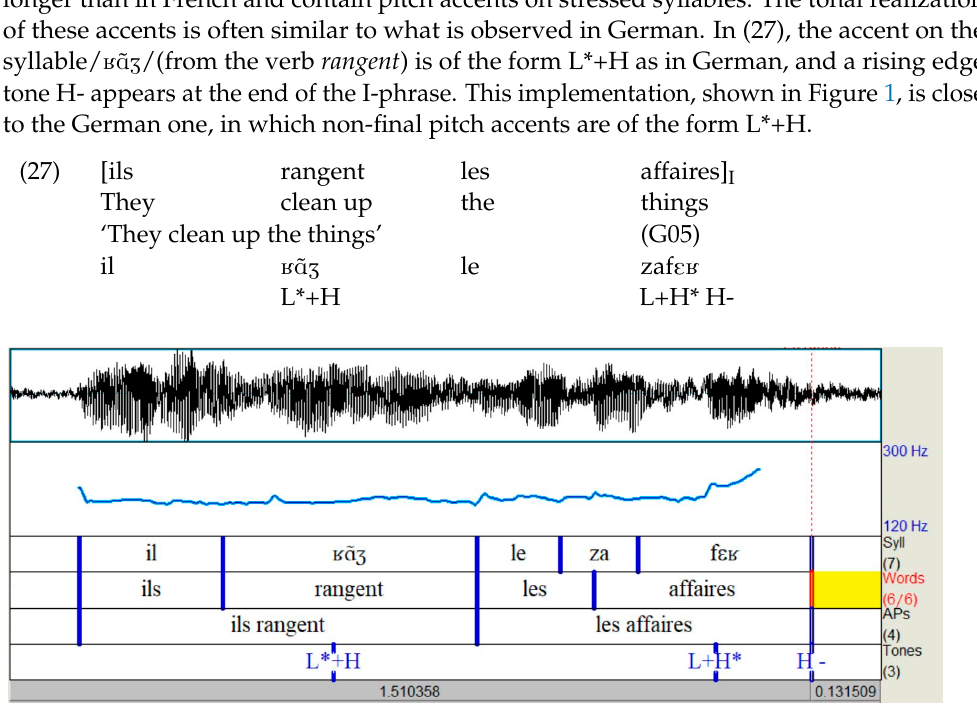
Figure 1. Waveform and pitch track associated with (27).